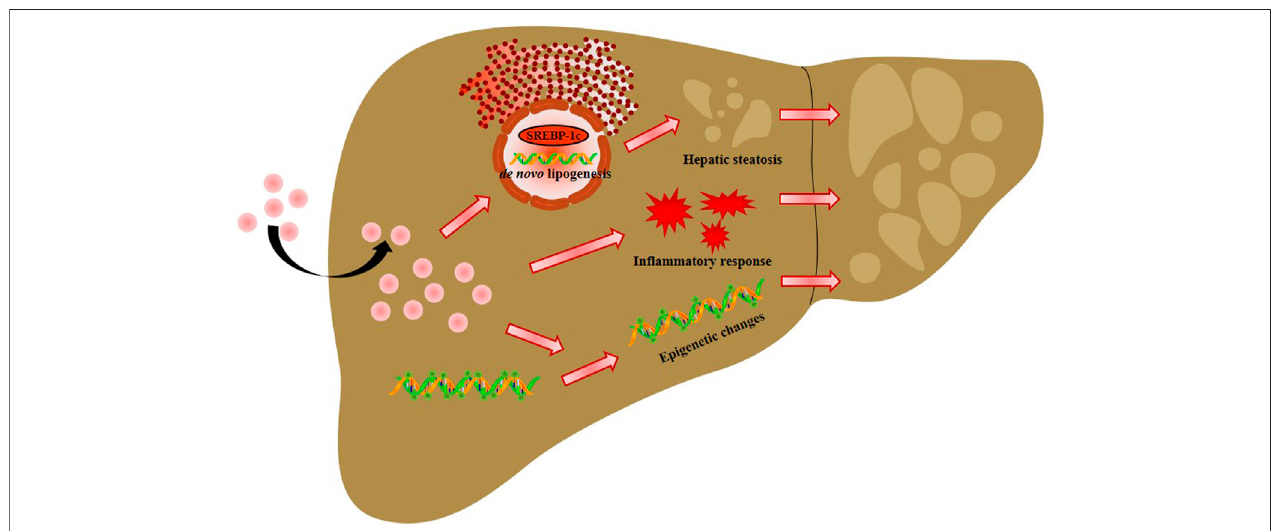
FIGURE 7 | Schema of the possible mechanisms of intravenously injected AgNPs on NAFLD development and progression. The potential mechanism of AgNP- induced hepatotoxicity in NAFLD mice is associated with hyperactivation of SREBP-1c-mediated de novo lipogenesis and liver in fl ammation. Additionally, signi fi cantly higher oxidative damage and lower global DNA methylation and DNA hydroxymethylation were observed in HFD-fed mice treated with AgNPs compared with NAFLD group. Thisstudysuggests thatAgNP treatment exacerbatedHFD-inducedhepatic steatosis,liverin fl ammation,oxidativestress,andepigeneticchangesinmice, which is relevant to the risk of AgNP exposure on NAFLD development and